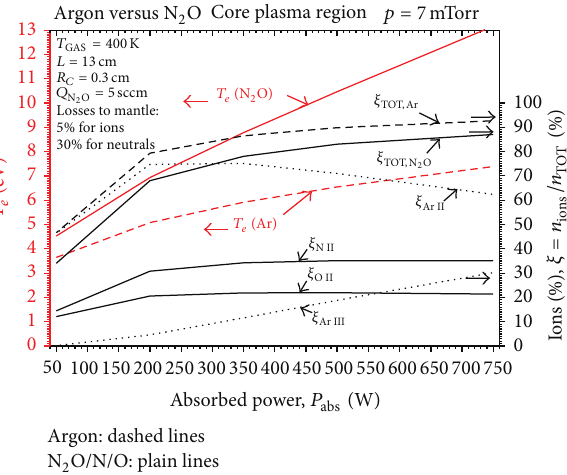
Figure 10: Variation of the densities of species for 7 mTorr in the “core” region of a N 2 O fed HPT as a function of absorbed power.